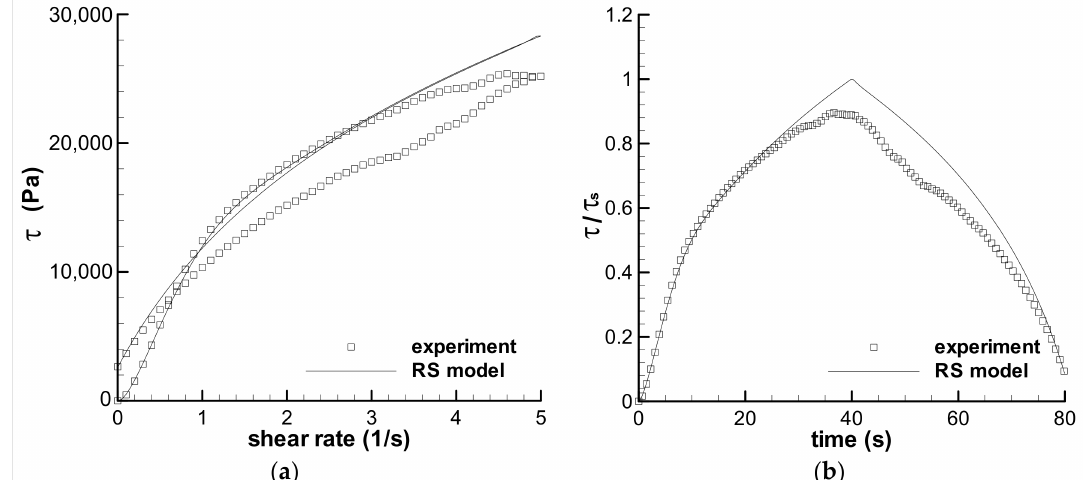
Figure 9. Prediction of the triangular-loop experiment with the characteristic time t 0 of 40 s. The stress–shear rate curve with maximum shear rates of 5 s − 1 is given in ( a ), and the corresponding stress–time curve is in ( b ). Symbol is experiment, line is the calculation by the RS model, and τ s is the steady shear stress calculated by the RS model at the maximum shear